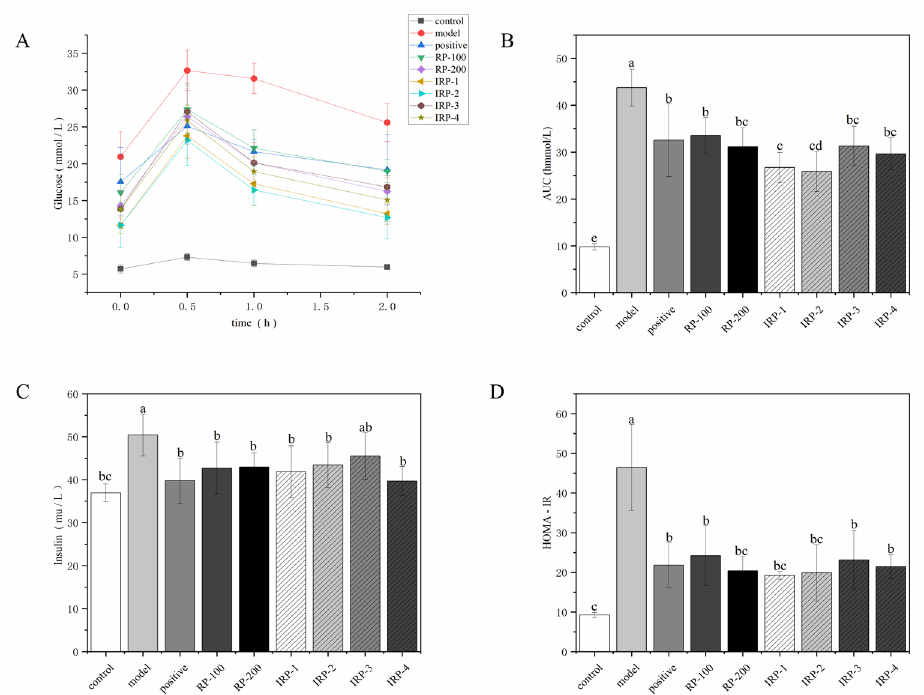
Figure 2. Effects of RP and IRP 1–4 on glucose intolerance and ameliorated insulin resistance in db/db mice. ( A ) oral glucose tolerance test, ( B ) AUC of glucose, ( C ) fasting serum insulin concentrations, ( D ) HOMA-IR. Data are presented as mean ± SD ( n = 6). Different letters (superscripts a–e) are significantly different at p < 0.05.